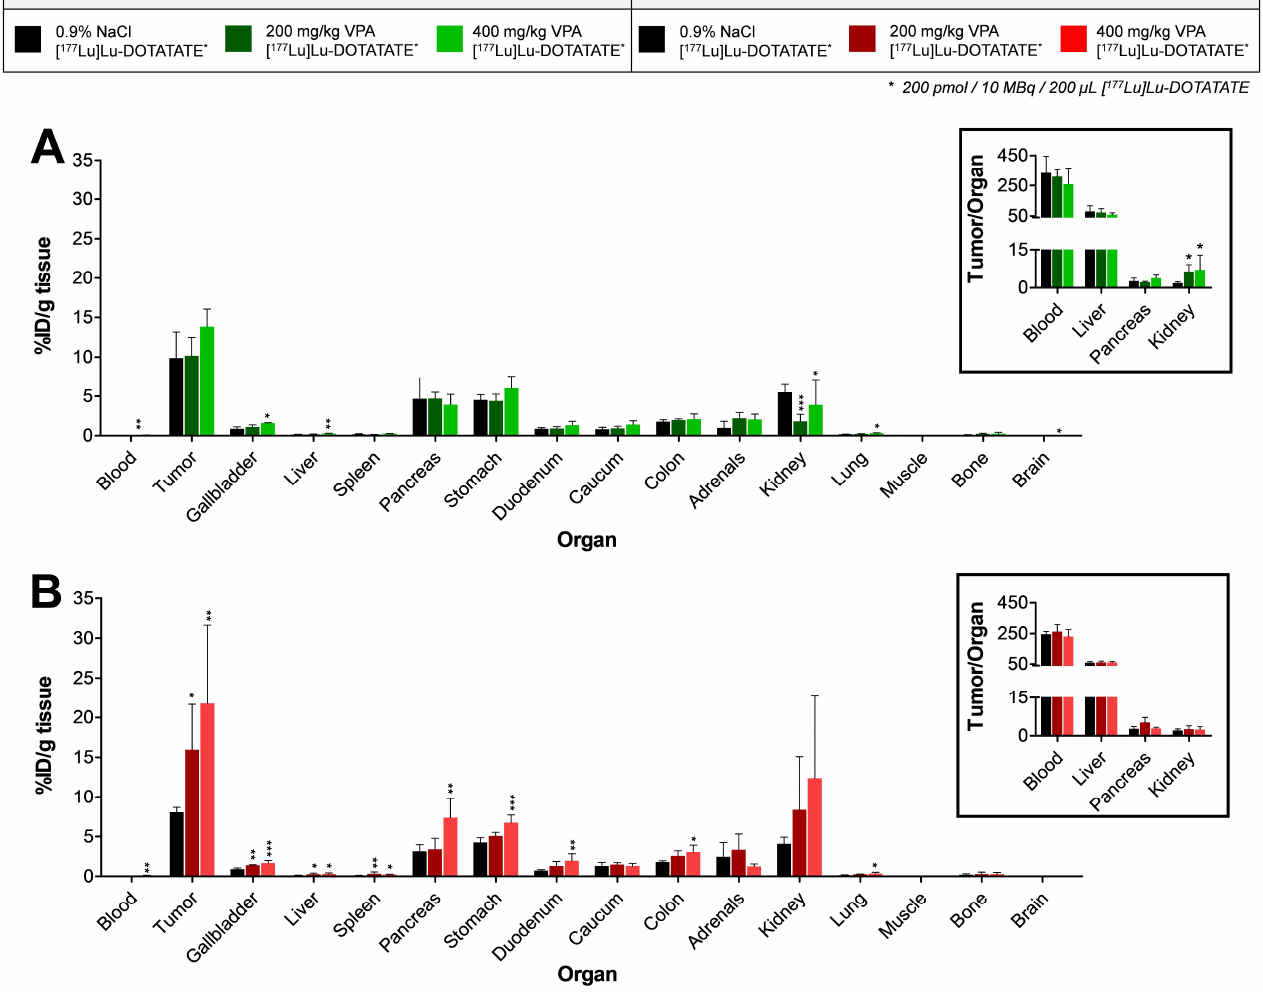
Figure 2. Biodistribution of [ 177 Lu]Lu-DOTATATE after VPA treatment [ 177 Lu]Lu-DOTATATE uptake expressed as percentage injected dose per gram tissue (% ID/g tissue) for animals injected with vehicle or VPA (200 mg/kg or 400 mg/kg) four ( A ) or eight ( B ) hours prior to [ 177 Lu]Lu- DOTATATE administration. For both treatment schedules, several tumor-to-organ ratios are depicted: * p < 0.05; ** p < 0.01; *** p <